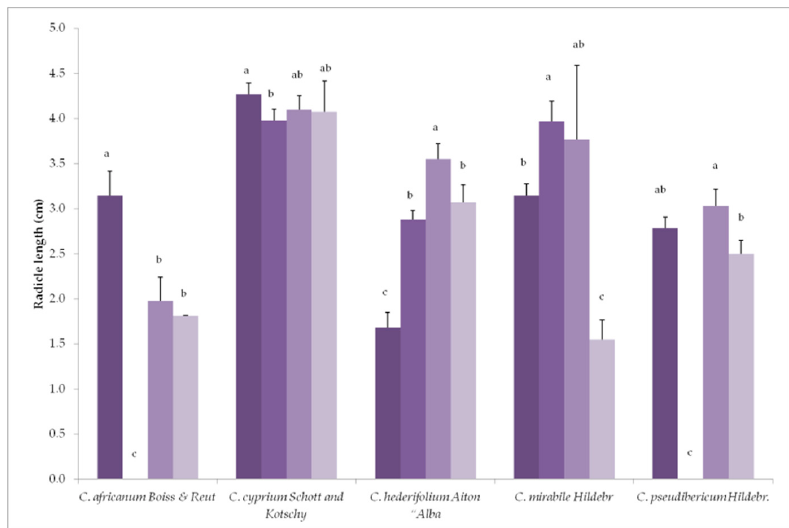
Figure 4. Variation of morphological parameters in Cyclamen species based on different concentration of gibberellic acid (GA 3 ). Different lowercase letters above the bars indicate significant differences between treatments, for each genotype, according to the Tukey’s HSD test ( p < 0.05). The plants’ height was measured from the highest point of the leaf to the beginning of the tuber.